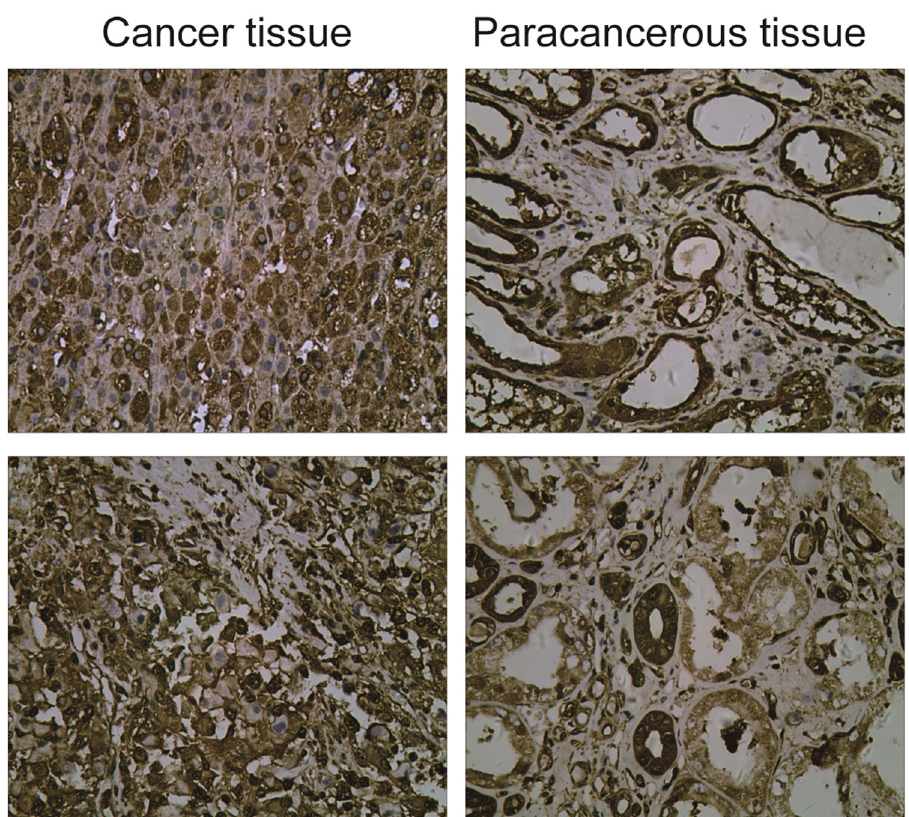
Figure 5: Immunohistochemical detection of Trim24 expression in renal carcinoma and paraneoplastic tissues. Representative pictures of immunohistochemistry in cancer and paraneoplastic tissues.